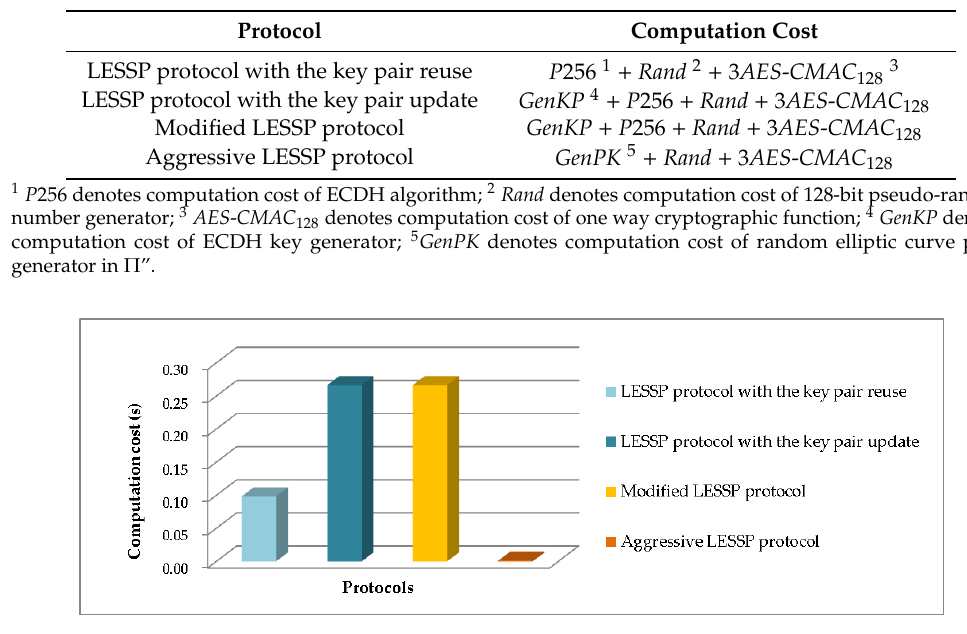
Figure 12. Experiment comparison of computation time costs.